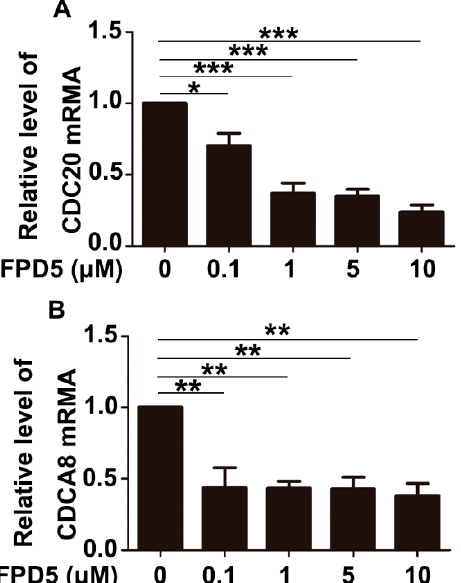
Figure 6. qPCR validation of p53 downregulated genes. ( A , B ): The mRNA levels of CDCA8 and CDC20 were detected by qPCR technology in A549 cells after treatment with 0, 0.1, 1, 5, 10 µ M FPD5 for 24 h. Data are mean ± SEM. * p < 0.05, ** p < 0.01, *** p < 0.001, n = 3.